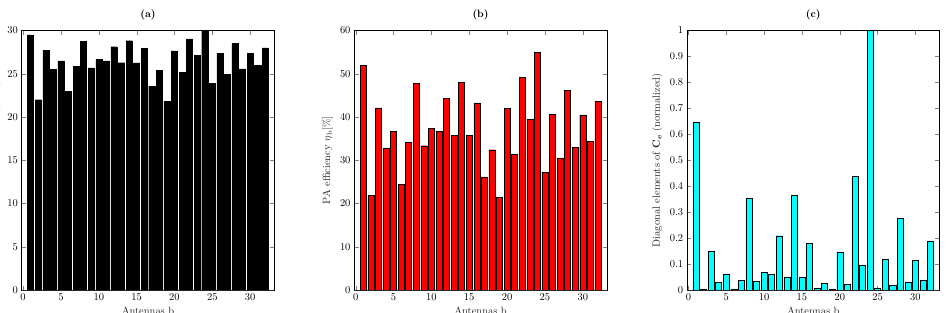
Figure 2. ( a ) Per-antenna transmit power values, ( b ) corresponding PA efficiencies, and ( c ) transmit- ted nonlinear distortion from different antennas. These results have been obtained by considering one realization of the geometric channel in (4) with B = 32, U = 4, and ZF precoding. The maximum output power is ρ ( b ) max = 30dBm and the maximum power efficiency of the PAs is η ( b ) max = 0.55 for b = 1, . . . , B . The nonlinearity characteristics of the PAs are as in (2) with K = 1, β ( b ) = − 0.0426 − 0.0191 j β ( b ) 3